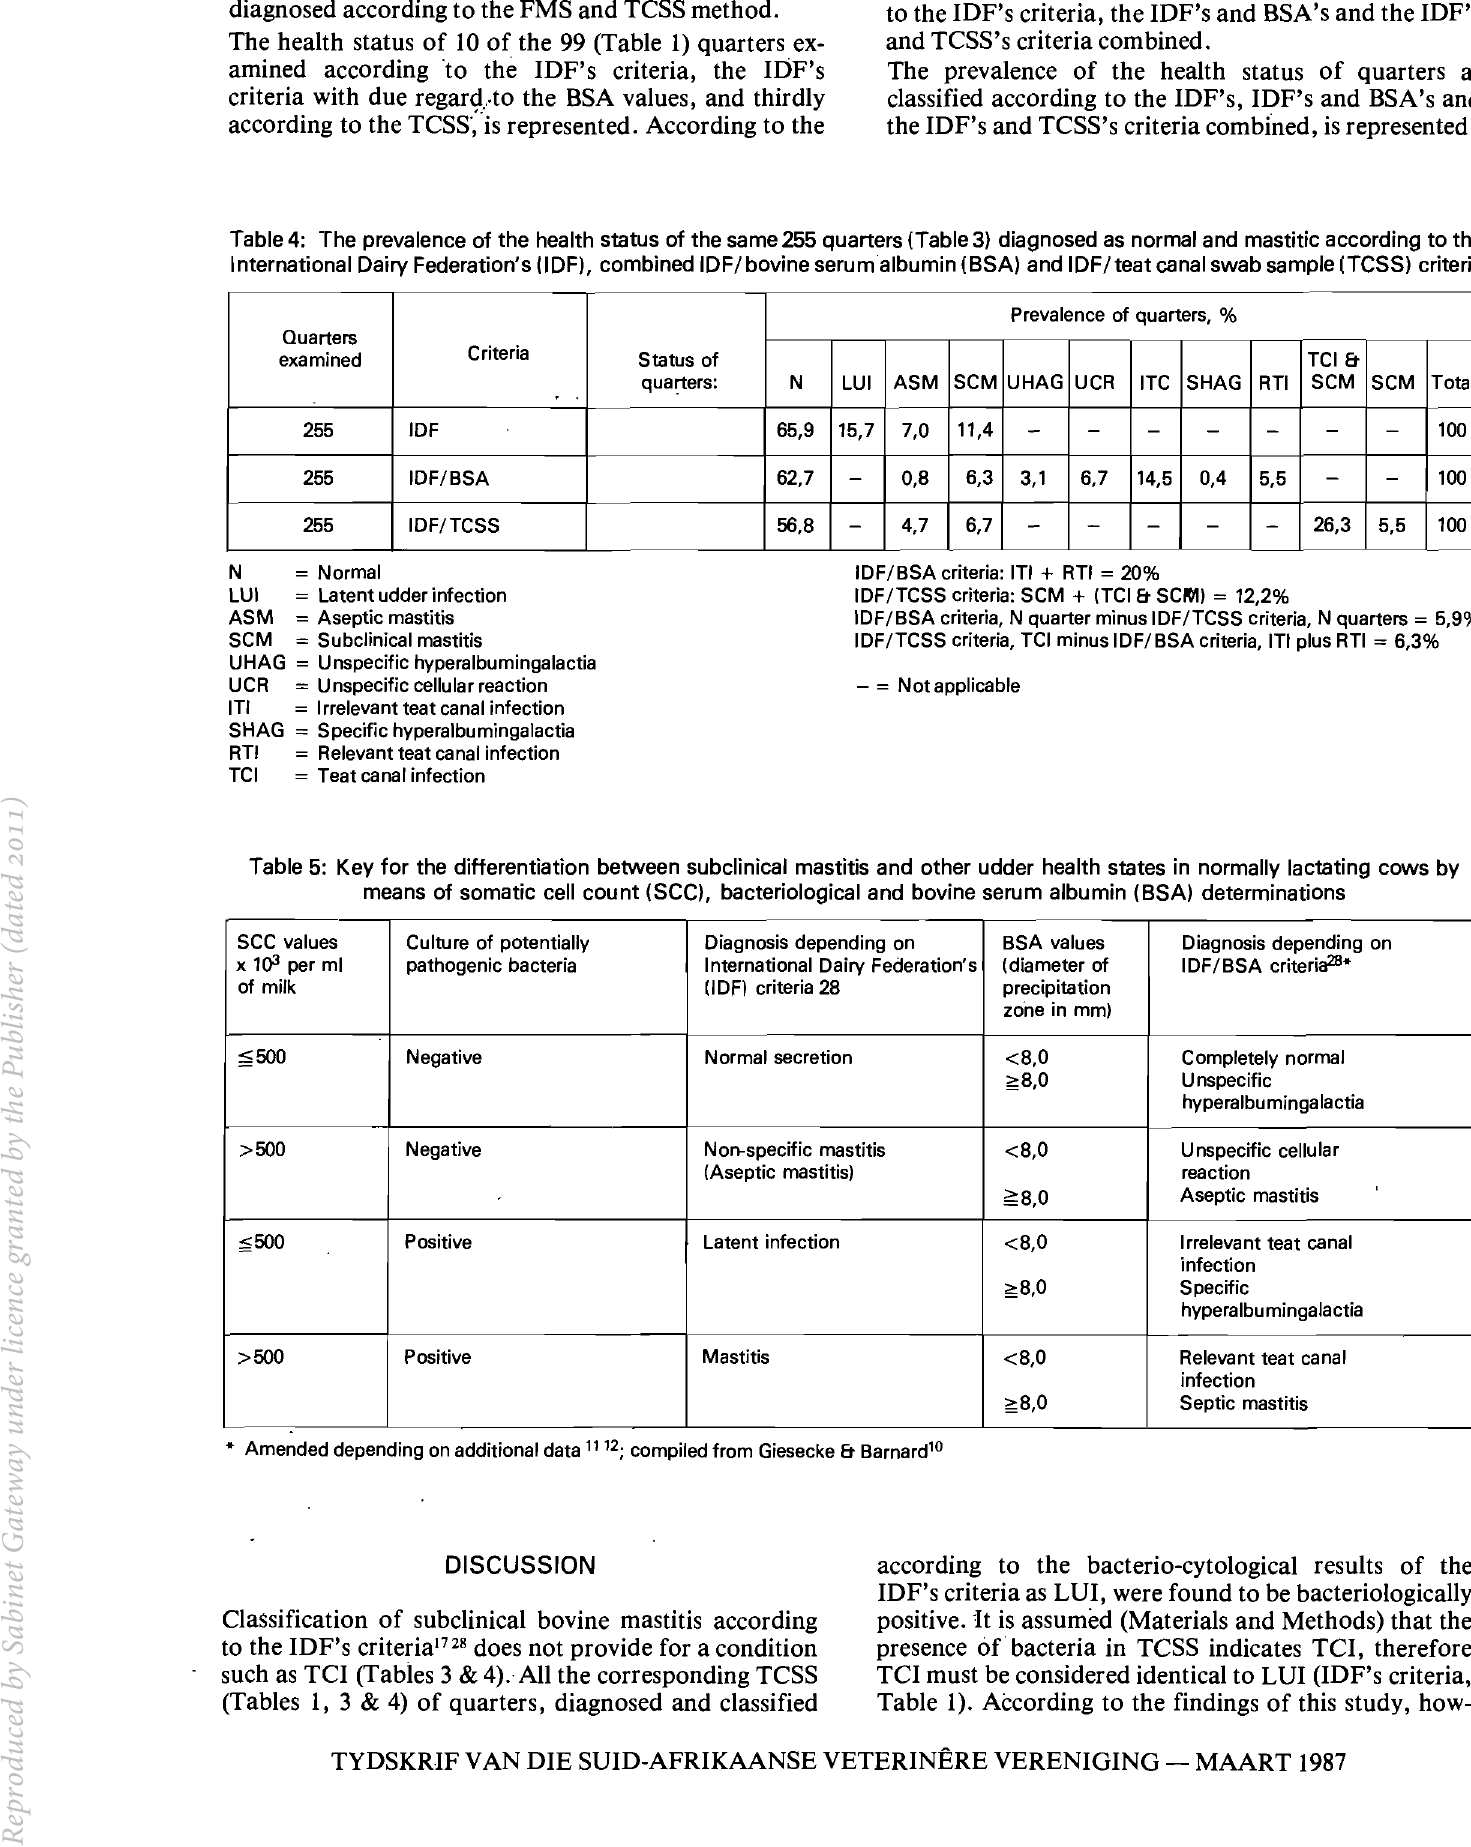
Quarters examined